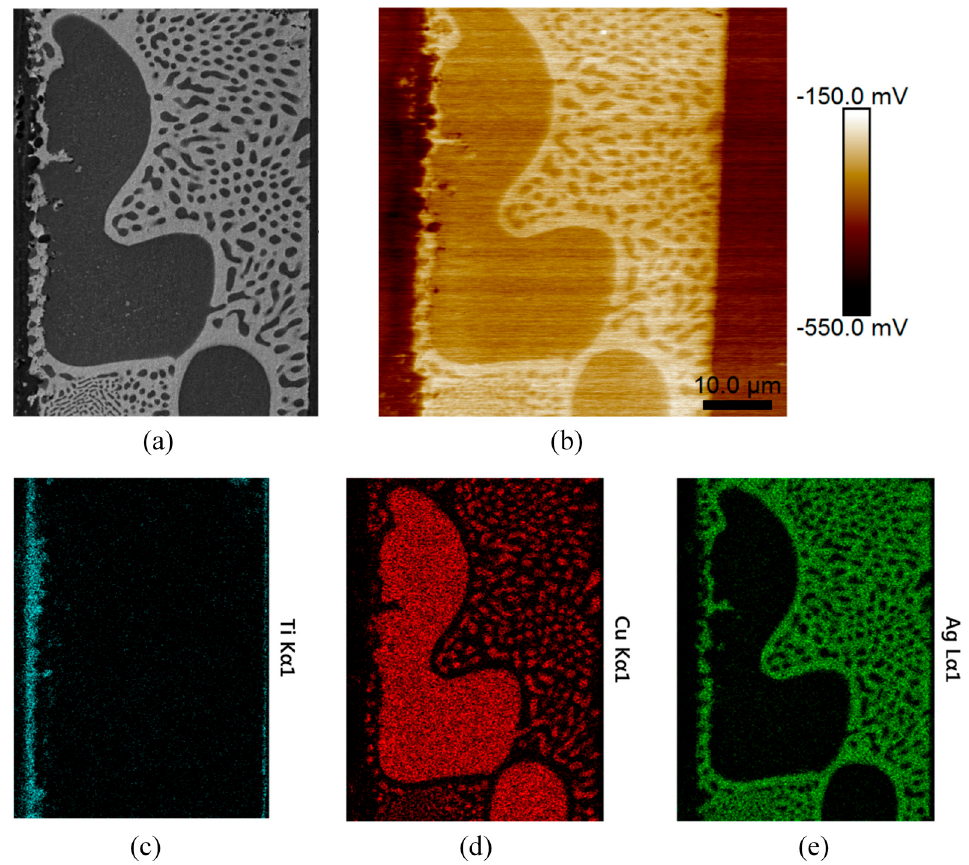
Figure 8. Secondary electron SEM image of Cu ‐ Ag ‐ Ti sample ( a ) followed by corresponding Scanning Kelvin Probe Force Microscopy (SKPFM) surface potential image ( b ). EDS elemental maps of the identical region for: Titanium ( c ); Copper ( d ); and Silver ( e ) are shown.